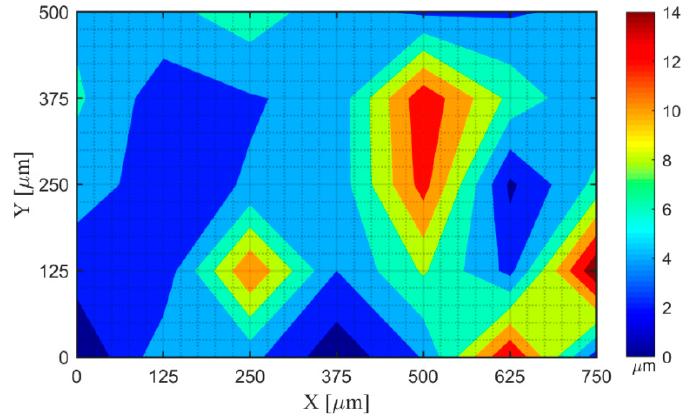
Figure 16. Contour of the errors between the certified and corrected points.